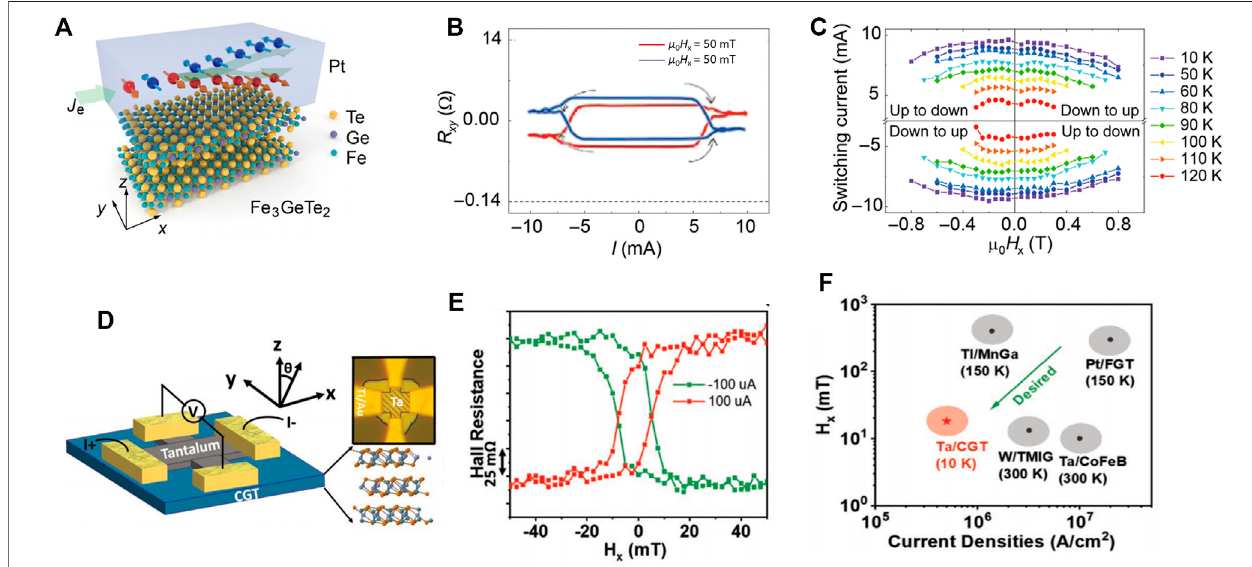
FIGURE 3 | 2D magnet/HM SOT devices: (A) Schematic of the FGT/Pt heterostructure (Wang et al., 2019). (B) SOT-driven magnetization switching for in-plane magnetic fi elds of 50 mT and − 50 mT on the FGT/Pt bilayer devices at 100 K. (C) Critical switching current as a function of the in-plane magnetic fi eld at different temperatures. The applied current of 1 mA corresponds to a current density of 1.85 × 10 10 A/m 2 in the Pt layer. (D) Schematic of the CGT/Ta heterostructure (Ostwal et al., 2020). (E) Field assisted SOT-driven magnetization switching with currents of 100 μ A and − 100 μ A at 4 K. (F) Assistant fi elds and current densities needed for SOT-driven switching of previous studies compared to the results obtained from CGT/